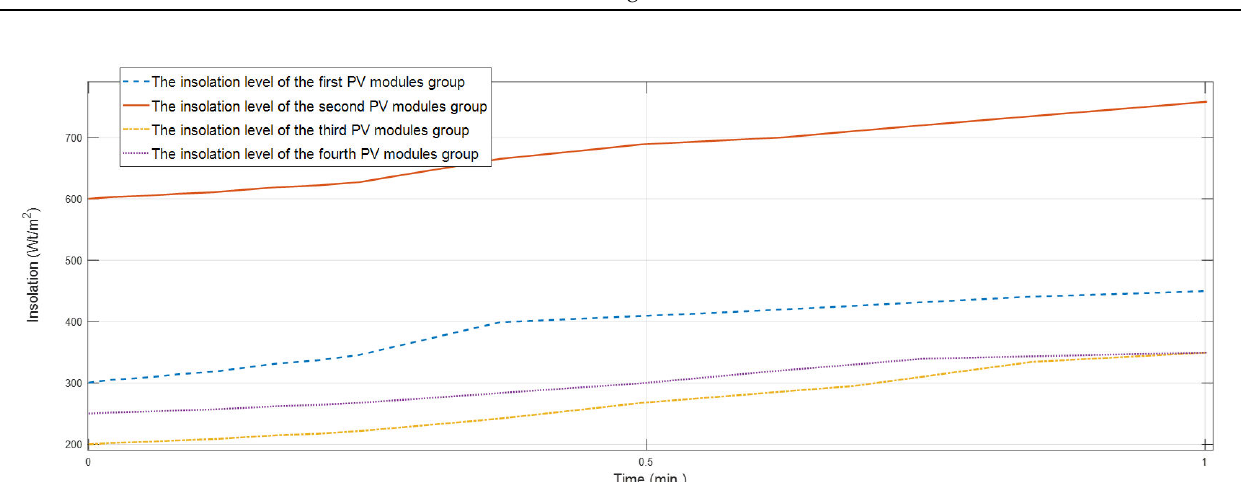
Figure 9. The solar panels groups’